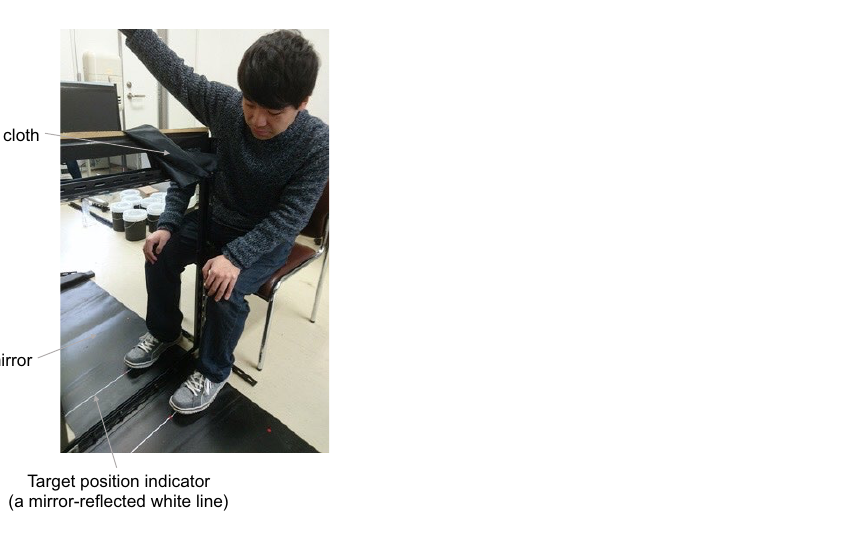
Figure 2. An experimental setup for the mirror foot condition. A mirror was positioned on the floor between the participant’s